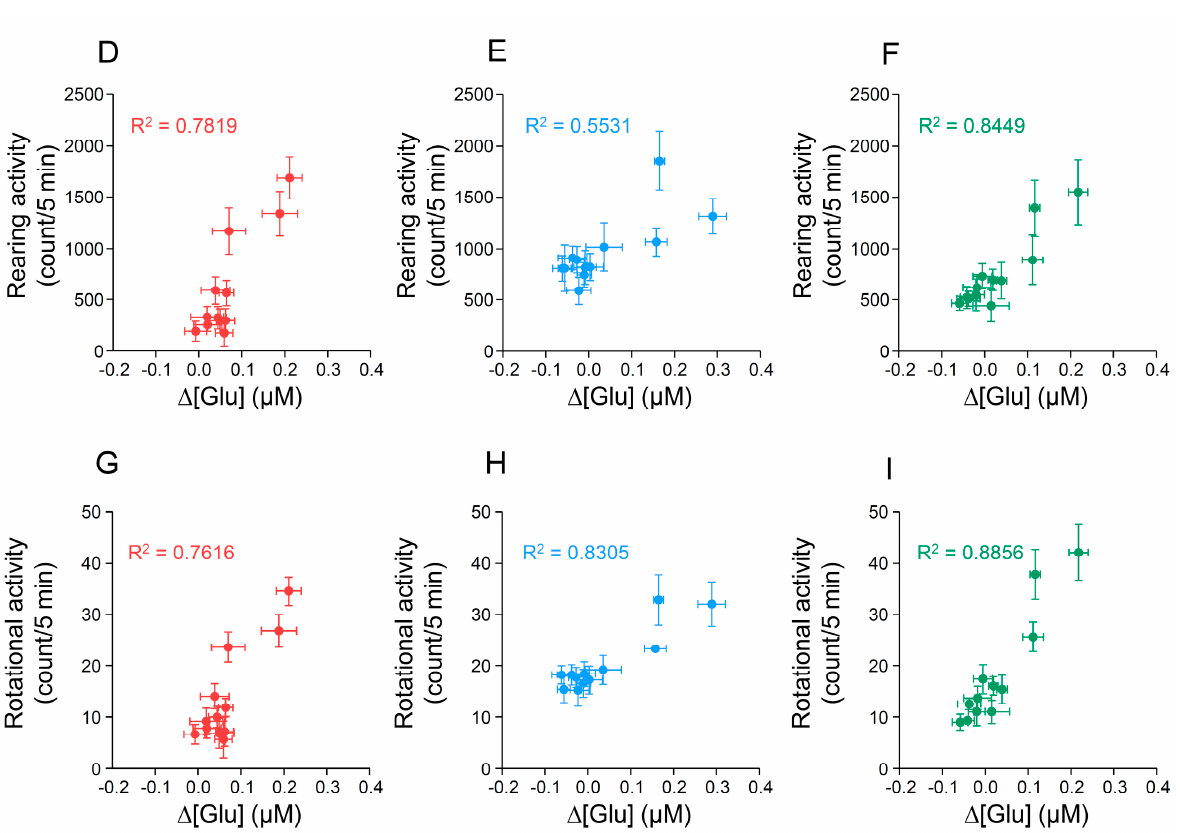
Figure 6. Correlation coefficients for the relationships between the rate of change in glutamate concentration ( Δ [Glu]) of the dorsal striatum and psychomotor behaviors after 14 days of repeated administration of two KCSCs.